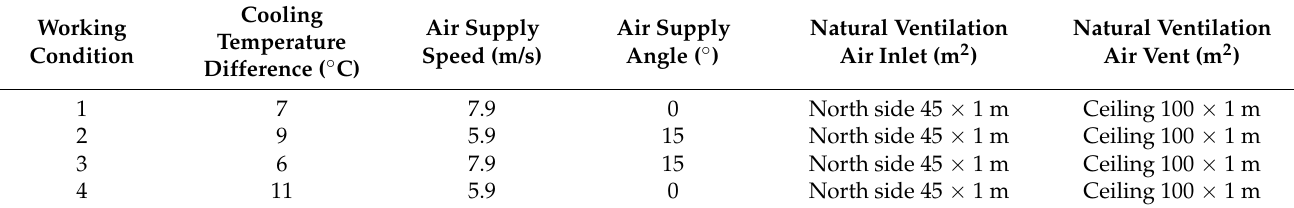
Table 6. Different working conditions